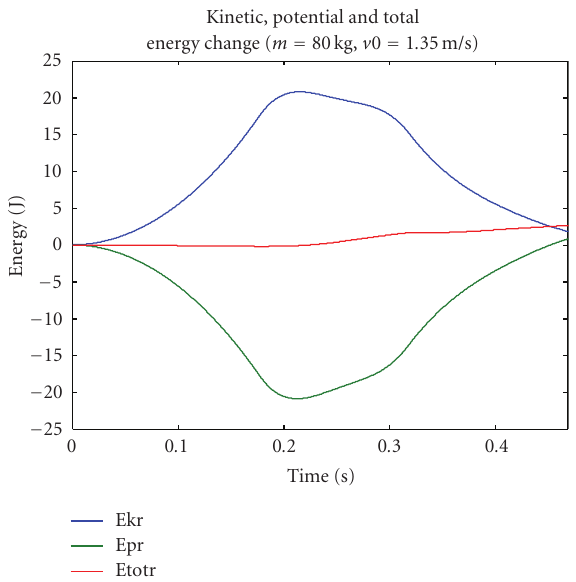
Figure 5: Potential, kinetic, and total mechanical energy change (relative energy with respect to the initial energy